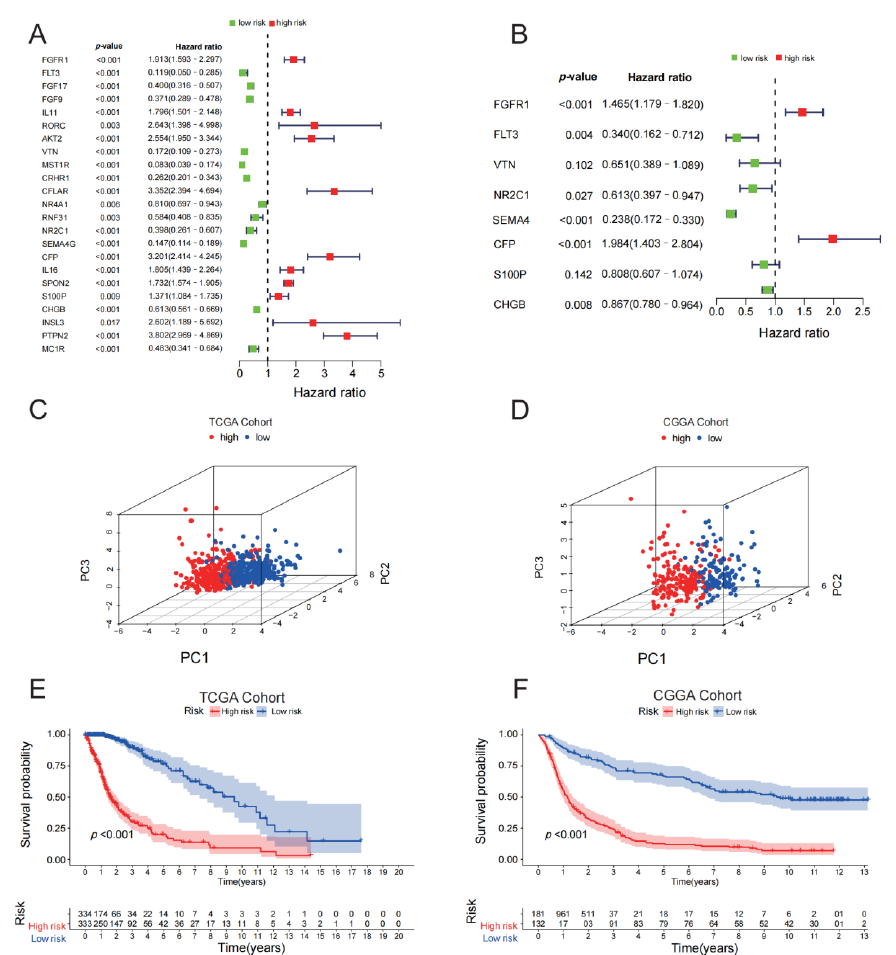
Figure 3. Construction of the immune gene-related prognostic score (IGRPS). ( A ) Univariate Cox analysis of 23 prognostic immune-related hub genes. ( B ) Eight signature IRGs identified by multivari- ate COX analysis. ( C , D ) Principal component analysis of eight signature IRGs. ( E , F ) Kaplan–Meier curves of different IGRPS subgroups in two